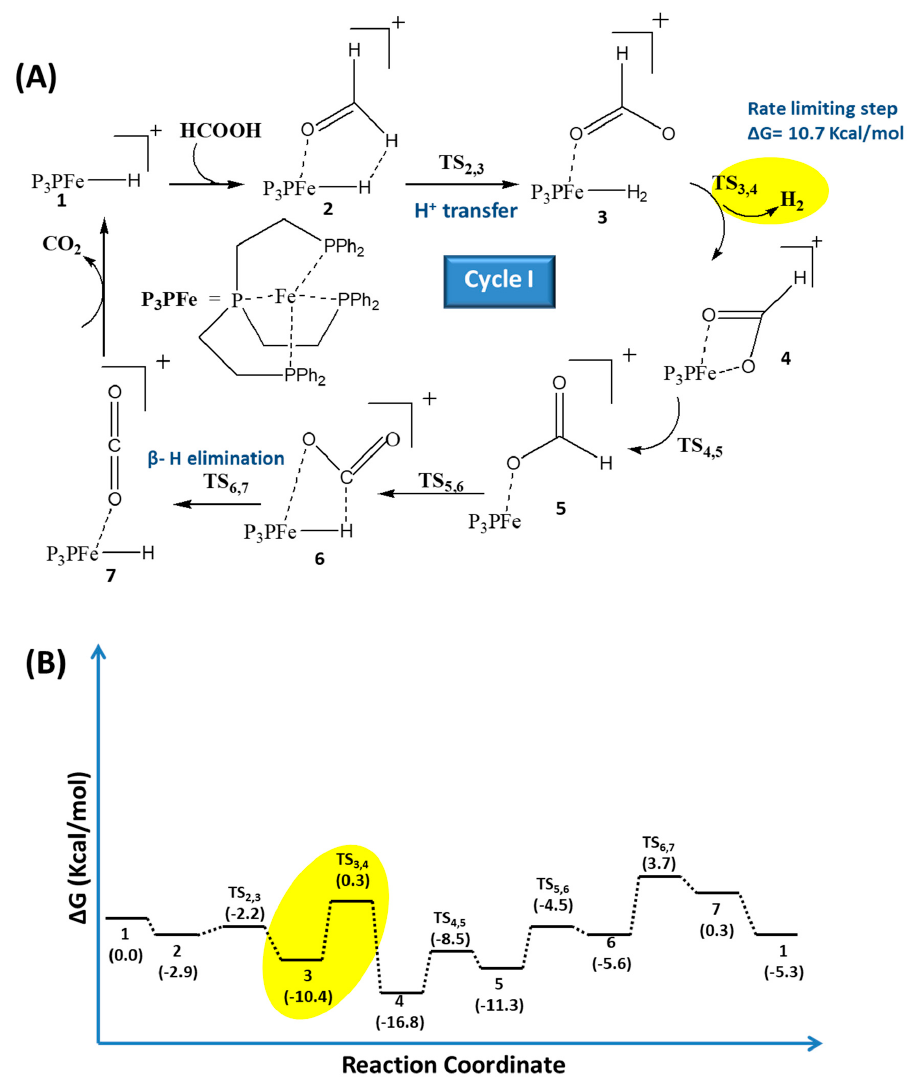
Figure 3. Catalytic (Cycle-I) for the [FePPh3 / HCOOH] system ( A ) and free energy profile ( B ). Figure adapted from Reference [52]. In Cycle-I, the reaction is rate-limited in transition state 3,4 by the H-H release from the Fe-center.